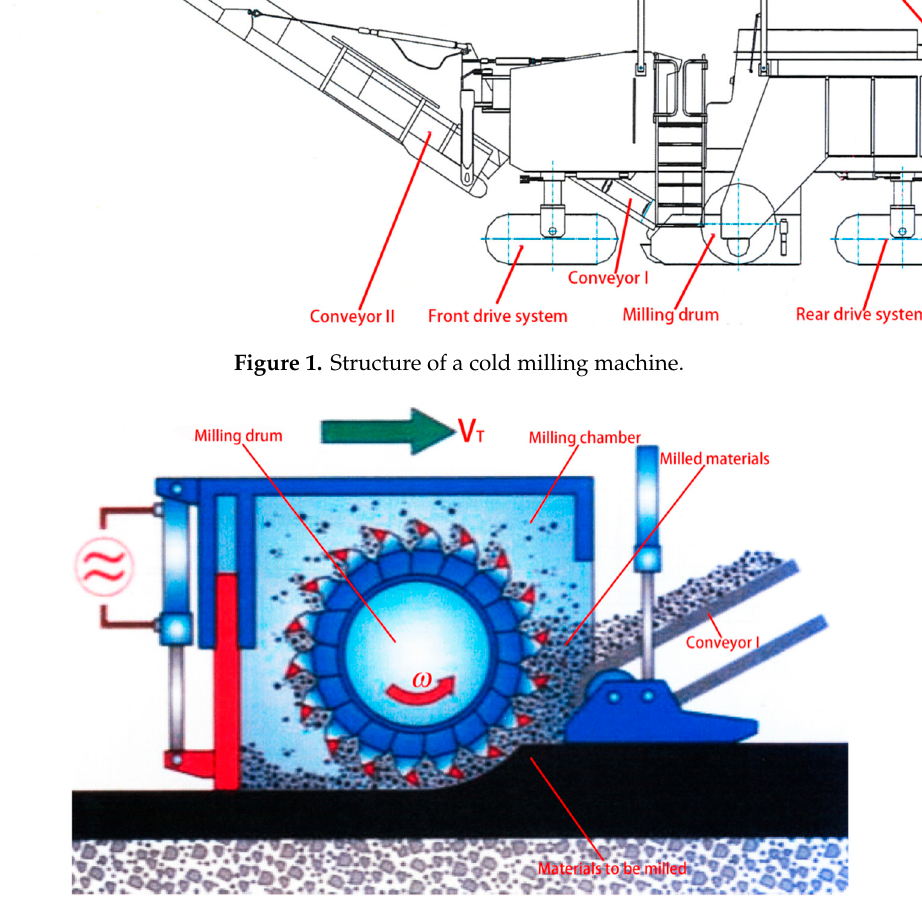
Figure 2. Working process of cold milling machine.